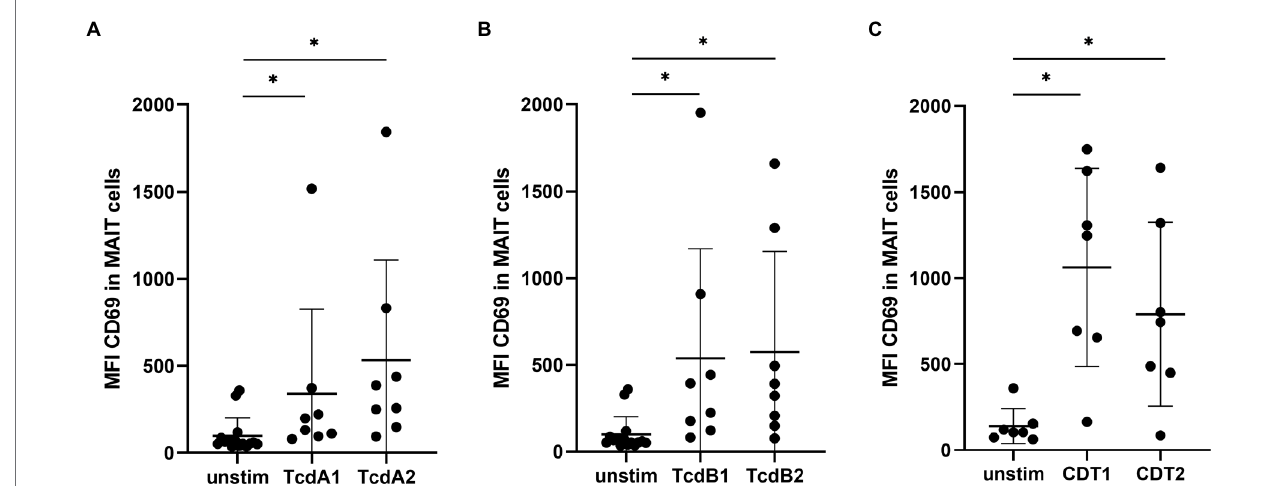
FIGURE 1 | C. difficile toxin-induced MAIT cell activation. PBMCs were isolated from healthy donors and stimulated with 100 ng/ml C. difficile toxin from two different production batches. TcdA1 or TcdA2 (A) , TcdB1 or TcdB2 (B) and CDT1 or CDT2 (C) stimulation for 20 h followed by flow cytometric analysis of mean fluorescence intensity (MFI) of total CD69 of MAIT cells. MAIT cells were gated on CD161 ++ V α 7.2 + CD3 + T cells. Data represent two to four independent experiments from seven to eight donors. Horizontal lines indicate mean ± SD. Asterisks indicate significant differences as determined by three Wilcoxon matched- pairs signed rank tests between all given conditions with Bonferroni Holm correction: * p < 0.05.